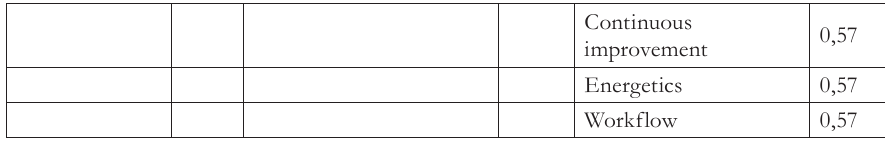
Criteria of the Process